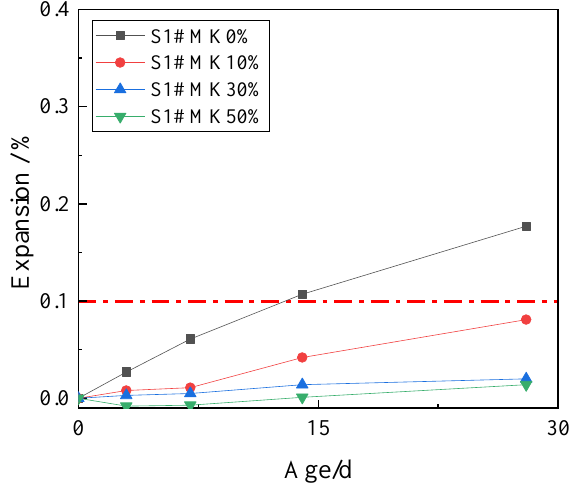
Figure 5. The expansion of the concrete microbars with metakaolin.